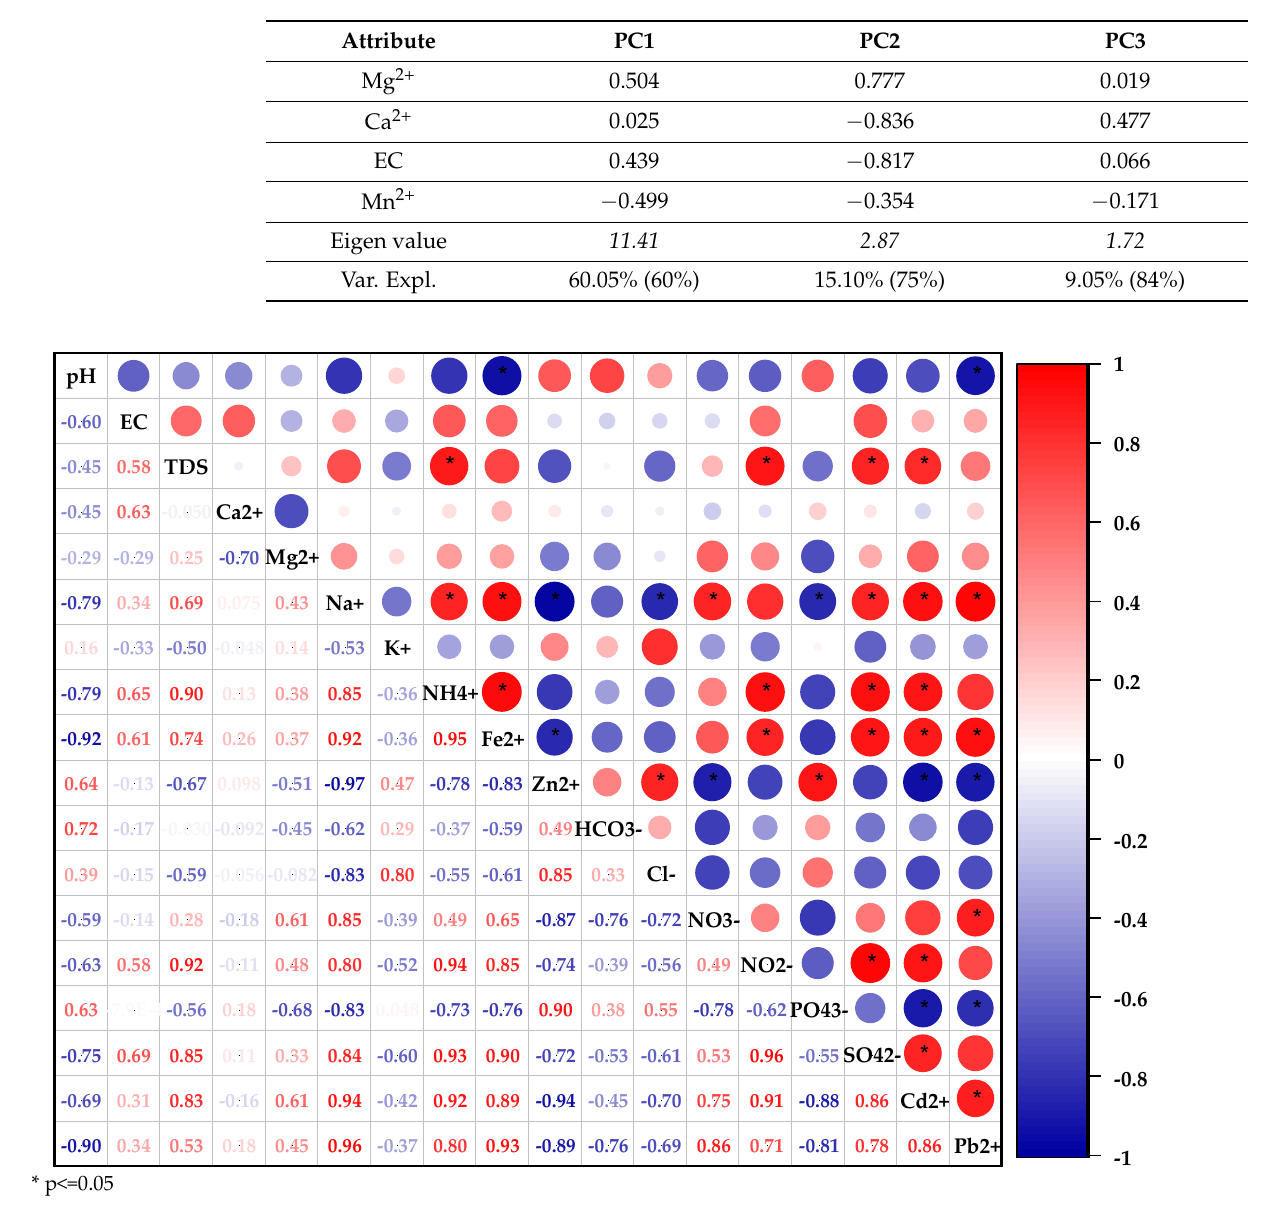
Figure 5. Matrix of the correlation coefficients of the physicochemical parameters of the alluvial aqui- fer.